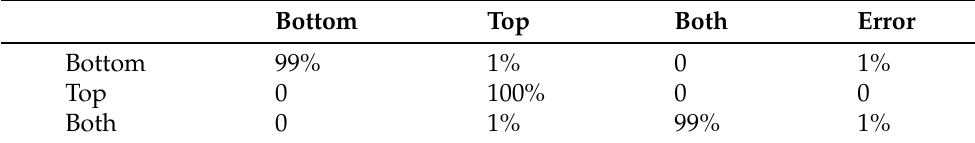
Table 7. Average confusion matrix using the power signal for feature extraction. Bottom